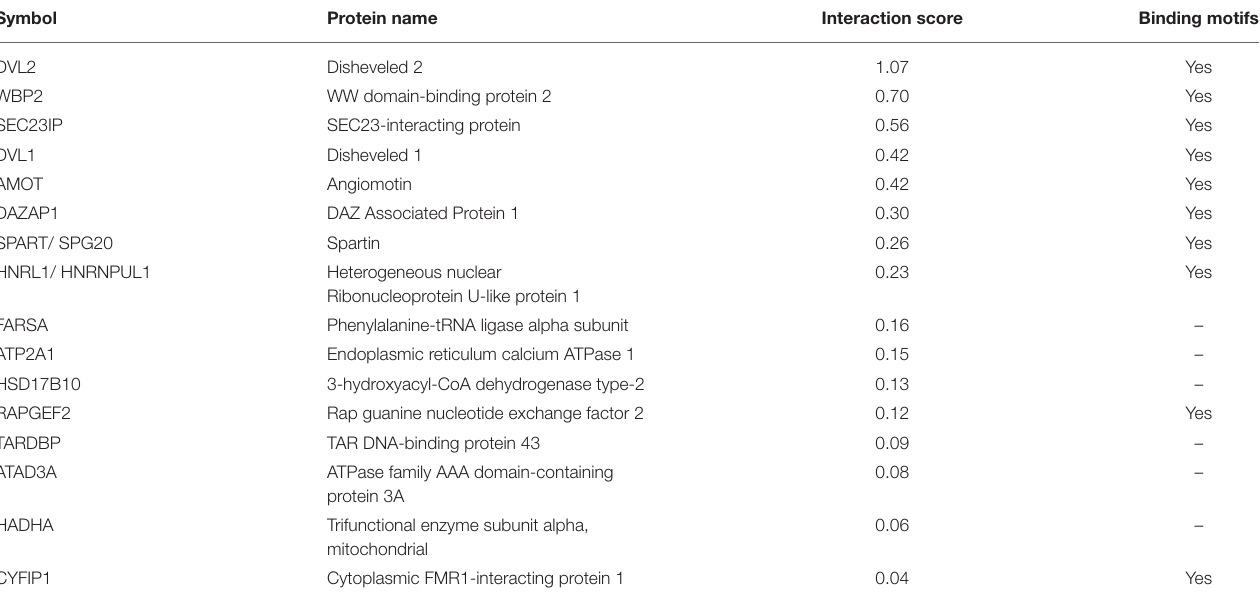
TABLE 2 | Common WWOX interactors identified in TAP-MS (this study) and Abu-Odeh et al. (34) datasets.